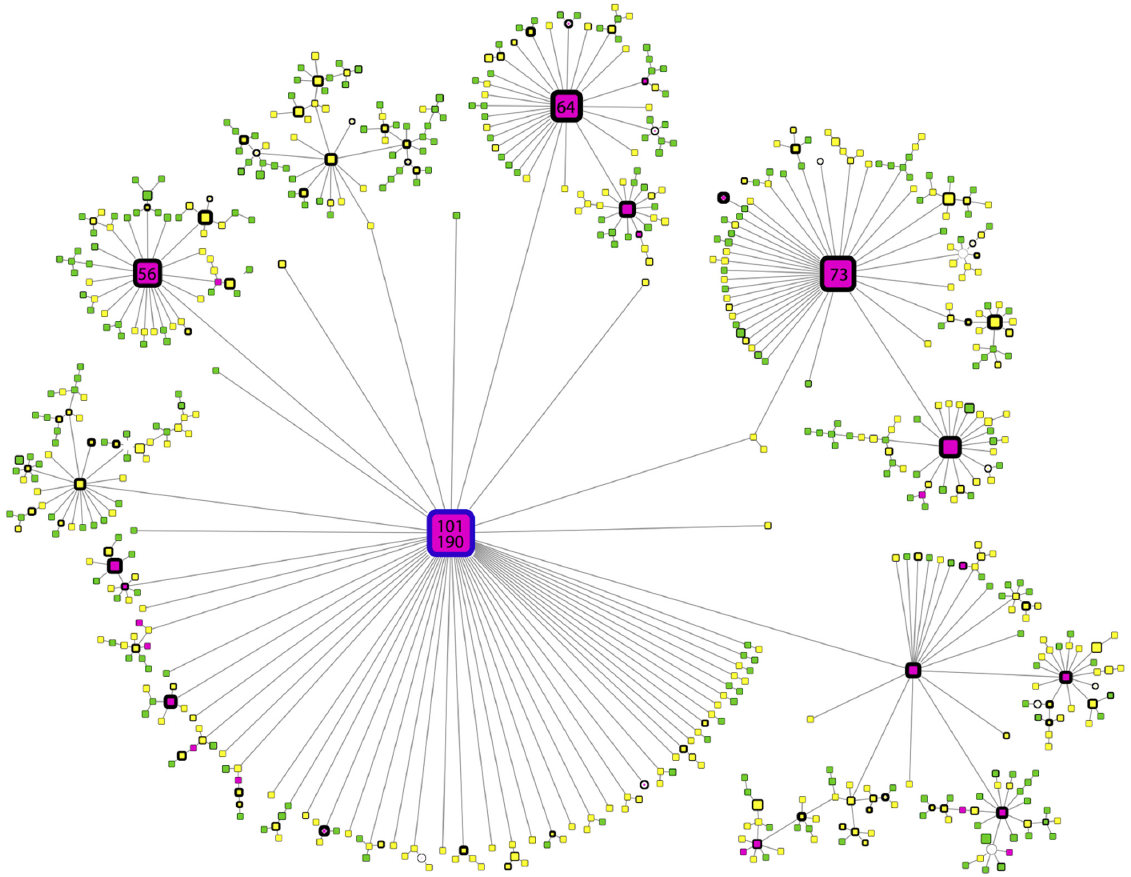
Figure 4. Haplotype network of B.1.1.519 sequences. Node colors represent the month of appearance (pink- fuchsia: November or December, yellow: January, February or March; green: April or May). Node size is proportional to the number of samples for that specific haplotype, and border width is proportional to the prevalence of the haplotype. Numbers correspond to the number of samples for that specific haplotype. The blue-bordered node indicates the haplotype with the most ancient appearance date for lineage B.1.1.519.